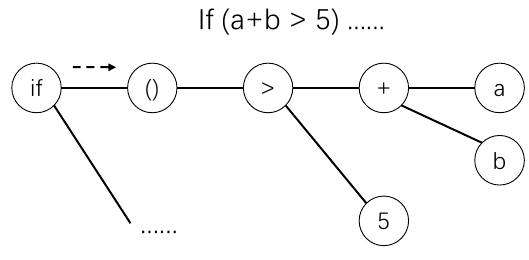
Figure 1. An example of an